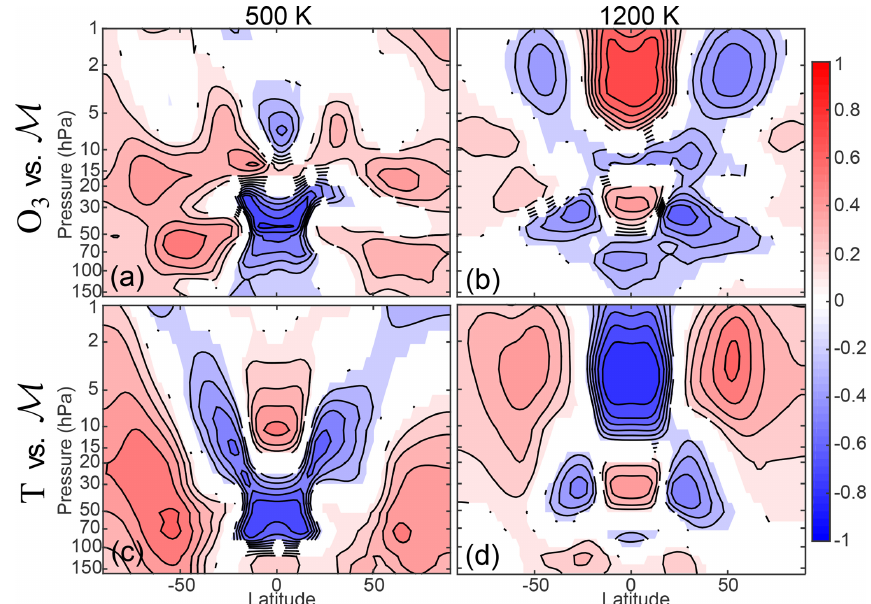
Figure 10. Correlation coefficient ( r ) of the interannual variability of local ozone concentration at every latitude and pressure with the global diabatic circulation at (a) 500K and (b) 1200K from WACCM. Correlation coefficient ( r ) of the interannual variability of local temperatures at every latitude and pressure with the global diabatic circulation at (c) 500K and (d) 1200K from WACCM. Contours are every 0.1, and correlations are only plotted where they are significant at the 95% confidence level.